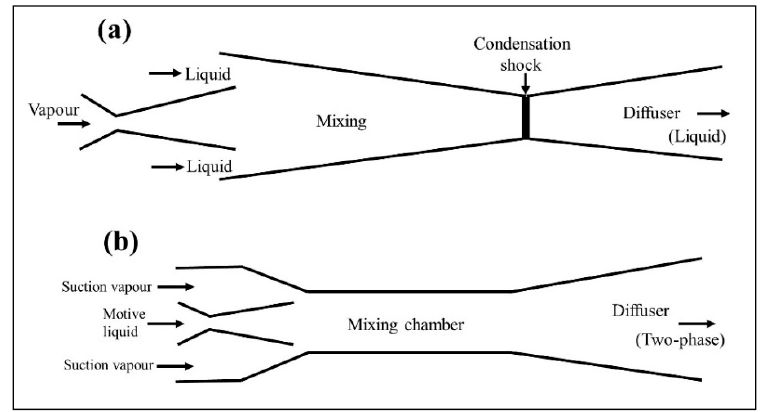
Figure 1. Typical geometry of two-phase ejectors: ( a ) vapor–liquid ejector; ( b ) liquid–vapor ejector.